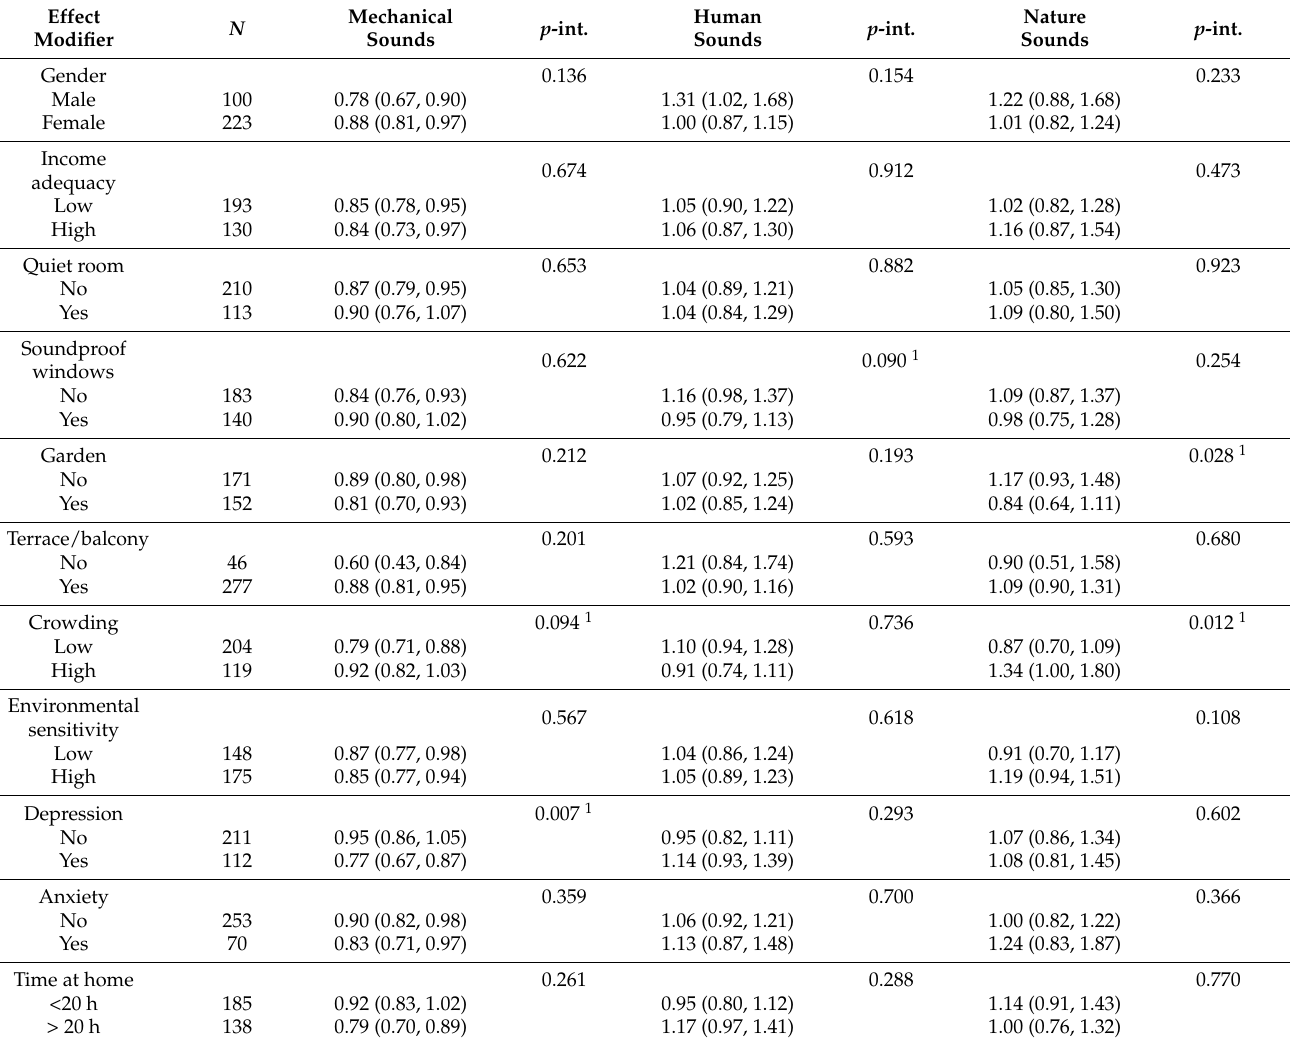
Table 6. Effect modification of the associations between perceived sounds and self-rated